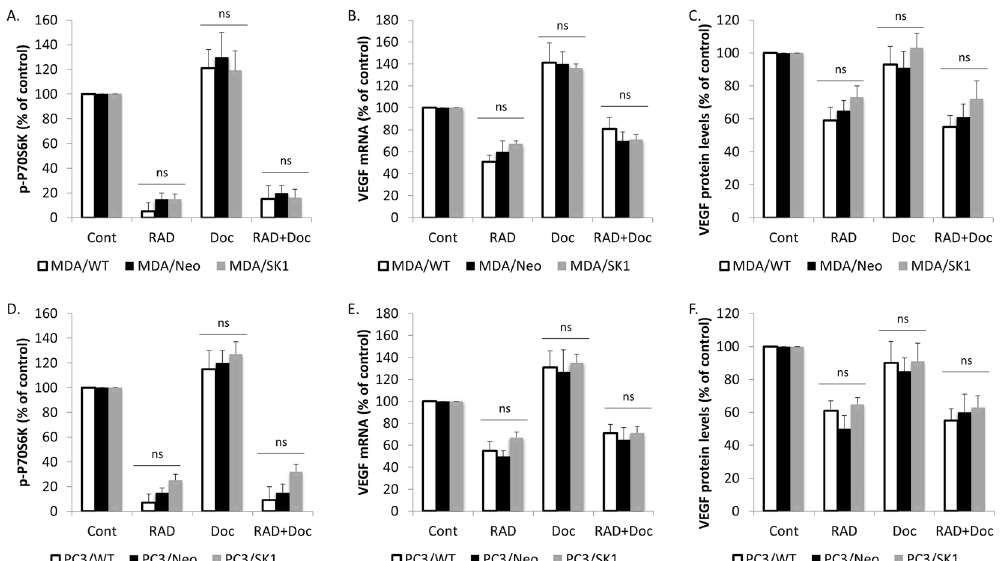
Figure 5. SK1 overexpression does not affect RAD001-induced VEGF downregulation. Wild type, empty vector- and SK1-overexpressing MDA-MB-231 and PC3 cells were starved overnight then incubated with 0.1% DMSO (Control), 100 nM RAD001 (RAD), 5 nM docetaxel (Doc) and the combination of these drugs (RAD + Doc) for 24 h. ( A , D ) P70S6K phosphorylation was measured using ELISA. ( B , E ) VEGF expression was determined by qRT-PCR. ( C , F ) VEGF protein levels were measured using ELISA. Columns, mean of three independent experiments performed in triplicate expressed as relative to control; bars, SEM. ( * P < 0.05; ** P < 0.01; § P < 0.001; ns, not significant, P >